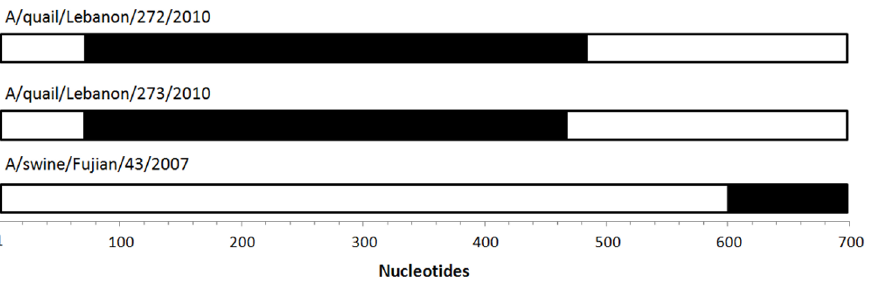
Figure 2. Recombinant detection in three incongruent sequences. The NS1-coding region of Lebanese sequences where two cross-over events were indicative of the introduction of a segment 99% similar to A/Puerto Rico/8/1934 (black boxes) of 425 nucleotides for A/quail/Lebanon/ 272/2010 and of 389 nucleotides for A/quail/Lebanon/273/2010, within a NS frame segment related to A/duck/Alberta/60/1976 (B group). These events were strongly supported by 3Seq (p=10 2 10 ), MaxChi (10 2 9 ), Chimaera (10 2 8 ), GENECONV (10 2 7 ), RDP (10 2 6 ) and BootScan (10 2 4 ) methods. In the case of A/swine/Fujian/43/2007, most of the segment is similar to the cluster of A/chicken/Rostock/8/1934 (NS1 A5), but one cross-over event was distinguished by nucleotide 592, introducing a 200-nucleotide region (beyond the end of NS1) 99% similar to A/Puerto Rico/8/1934 and supported by